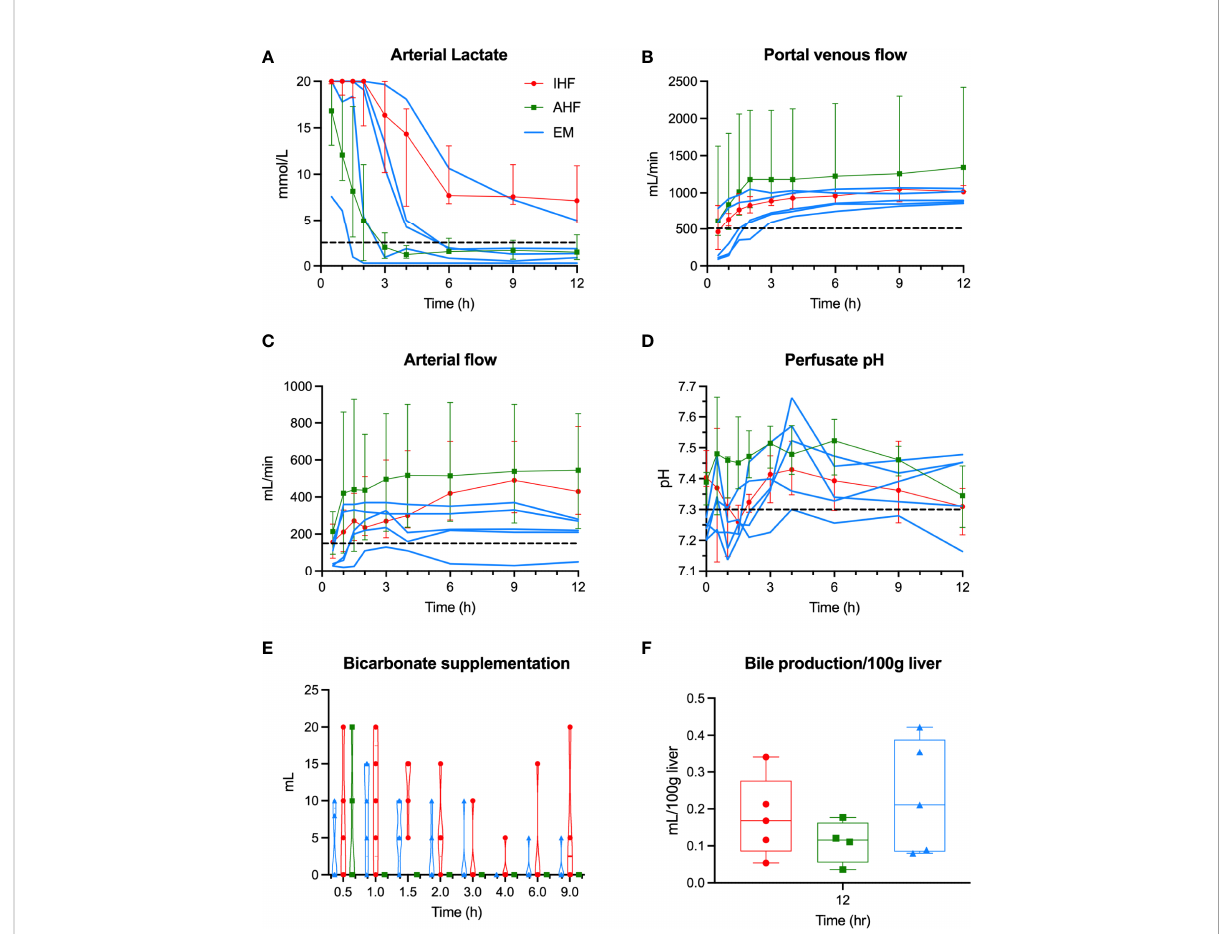
FIGURE 2 Hepatocellular perfusion metrics during NMP. Individual liver data for emricasan-treated livers (EM) shown in blue. Median and interquartile ranges shown for AHF (green) and IHF (red) groups. Dashed black line shows the cutoff used to determine adequate hepatocellular function for (A) arterial lactate, (B) portal fl ow, (C) arterial fl ow, and (D) perfusate pH. (E) Volume of bicarbonate supplementation required to maintain pH>7.3 show. Only the inadequate functioning EM liver continued to require bicarbonate after 2 hours of NMP. (F) Bile production shown for each group. No signi fi cant difference was seen though to livers in the AHF group were omitted due to technical issues with bile collection. NMP, normothermic machine perfusion; AHF, adequate hepatocellular function; IHF, inadequate hepatocellular function; EM,